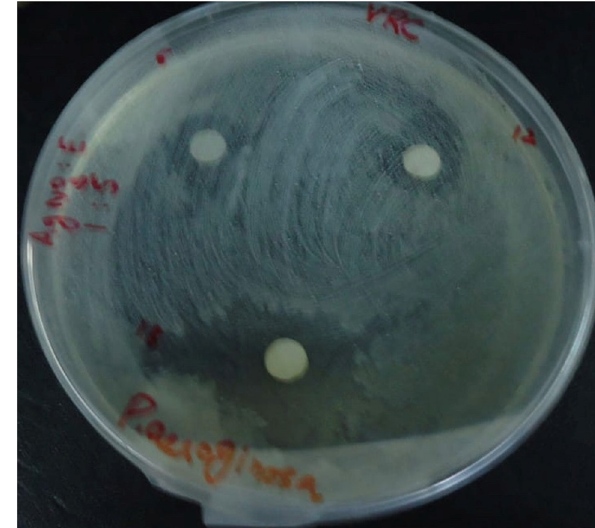
Figure A3: Antibacterial activity of AgNPs and crude methanolic extract of T. govanianum against P. aeruginosa by disc di ff usion